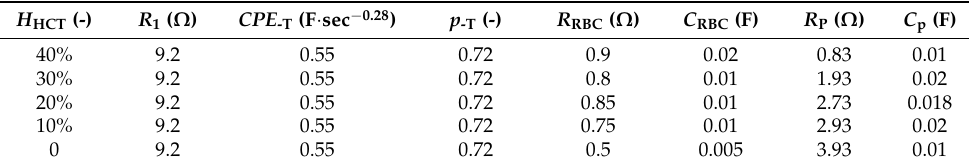
Figure 3. ( a ) Seven-parameter equivalent circuit of blood; ( b ) Fitting results: HRBC and relationship between H HCT and R p ; ( c ) The Nyquist plots of blood with different HCT and H HCT ; ( d ) Relationship between H HCT and Z Imt ; ( e ) Relationship between H HCT and Z Ret . Table 1. Fitting